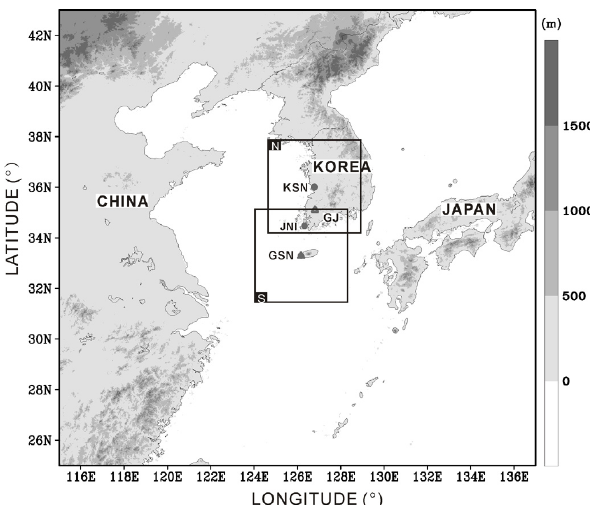
Fig. 1. Geographic map of Korean Peninsula in East Asia. Positions of Doppler radars ( • ) and upper-air sounding stations (GJ and GSN, N for 6-h interval) are shown. The boxes labeled “N” and “S” in- dicate the dual-Doppler radar analysis domains for KSN, JNI, and GSN